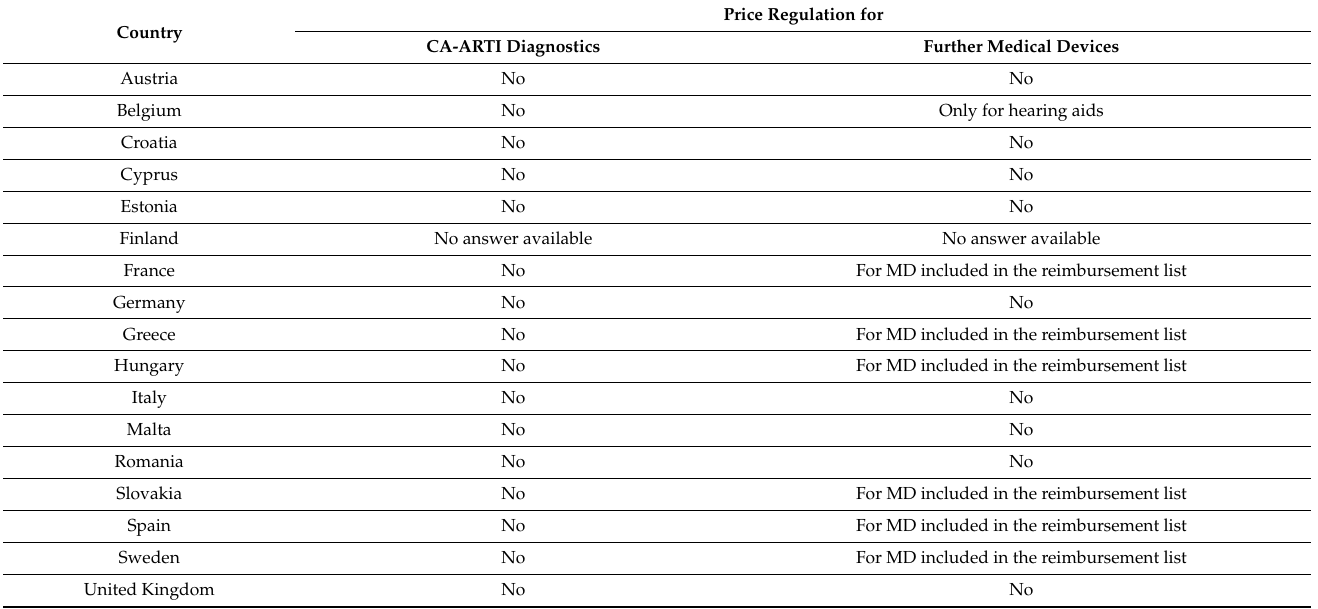
Table 1. Price regulation for CA-ARTI